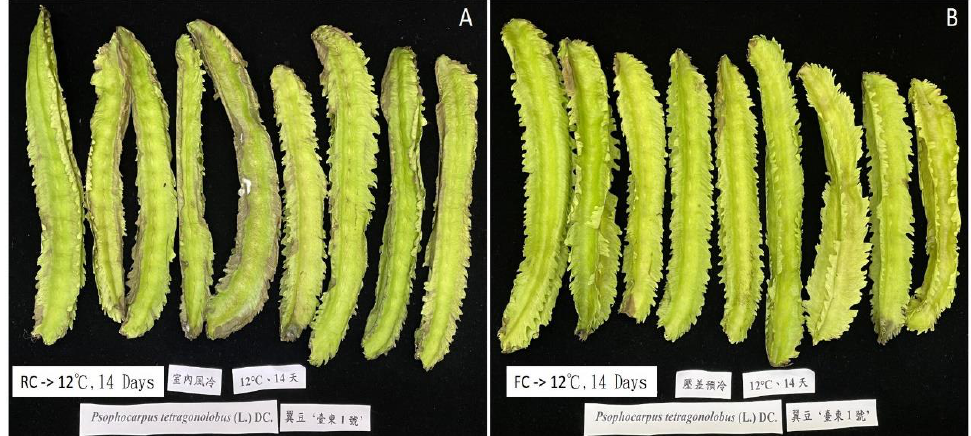
Figure 4. Pod appearance after FC and RC and storage at 12 °C for 14 days: ( A ) Room cooling. ( B ) Forced-air precooling.